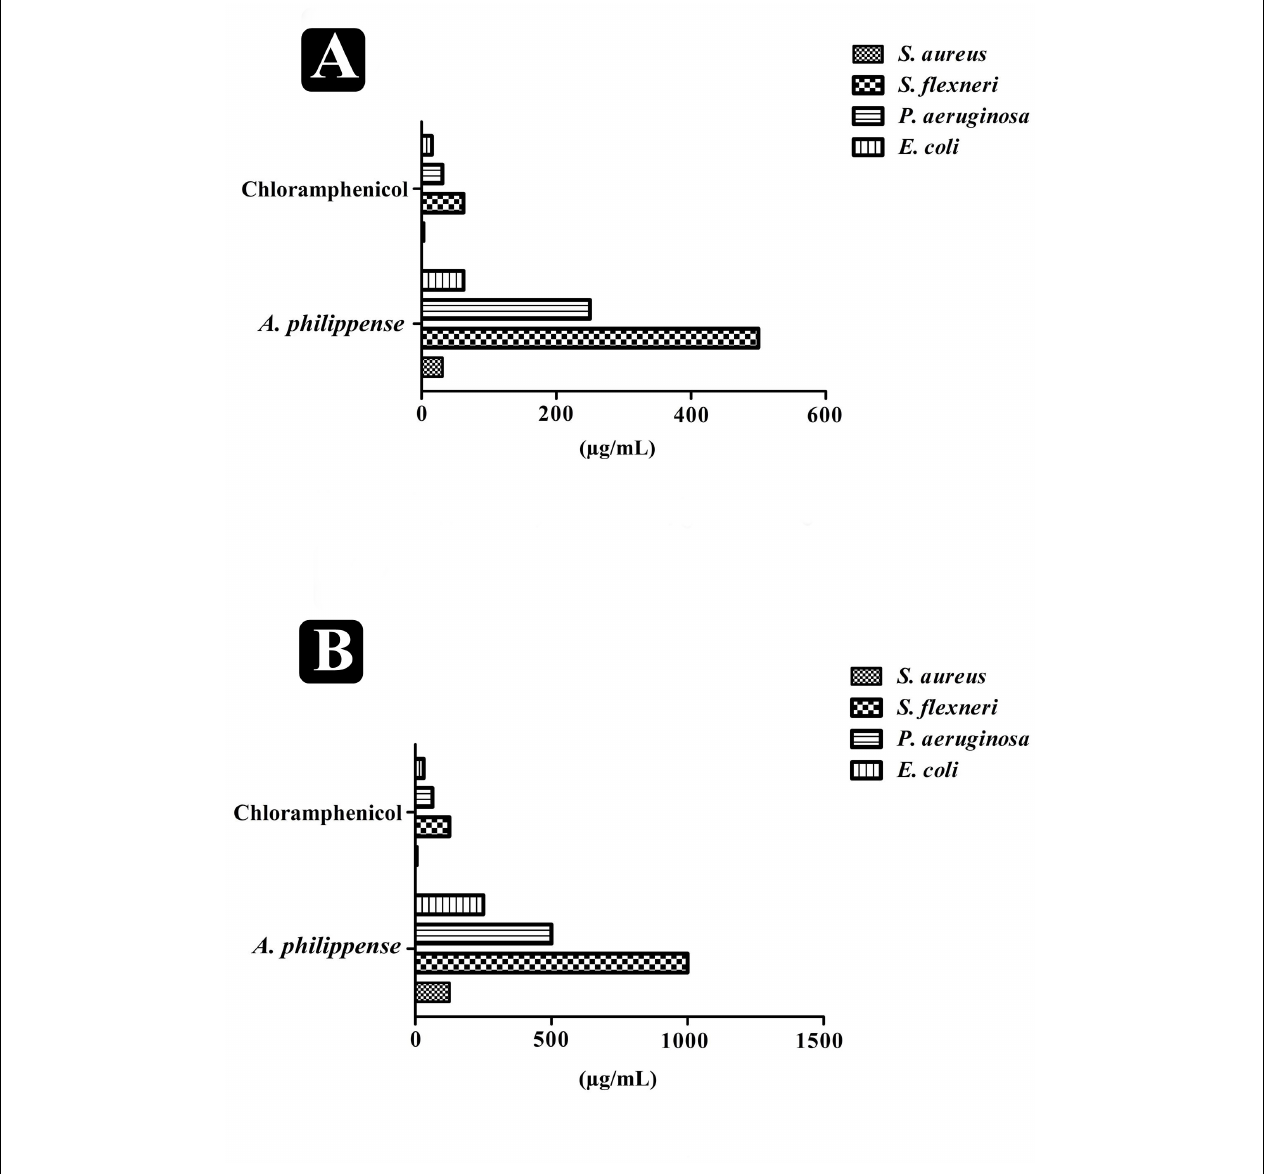
FIGURE 3 | Antagonistic potential of A. philippense crude extract. (A) Results of MIC of A. philippense crude extract and chloramphenicol; and (B) results of MBC of A. philippense crude extract and chloramphenicol.